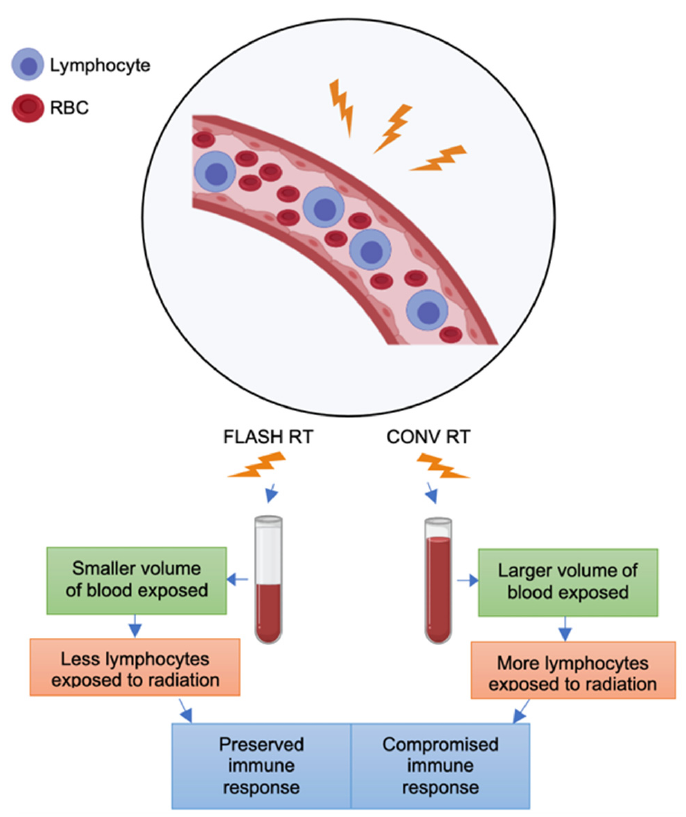
Figure 2. Immune hypothesis for the FLASH effect. Lymphocytes circulating within blood vessels are an important component of the immune response that influences tumor suppression. According to the immune hypothesis, the higher dose rates characteristic of FLASH-RT allow exposure of a much smaller volume of blood to radiation than CONV-RT. As a result, a higher number of circulating lymphocytes will survive and the immune response critical for tumor suppression is preserved to a greater degree. In contrast, the lower dose rates used in CONV-RT allow exposure of larger blood volumes circulating through the radiation field, leading to a significant loss of lymphocytes and a compromised immune